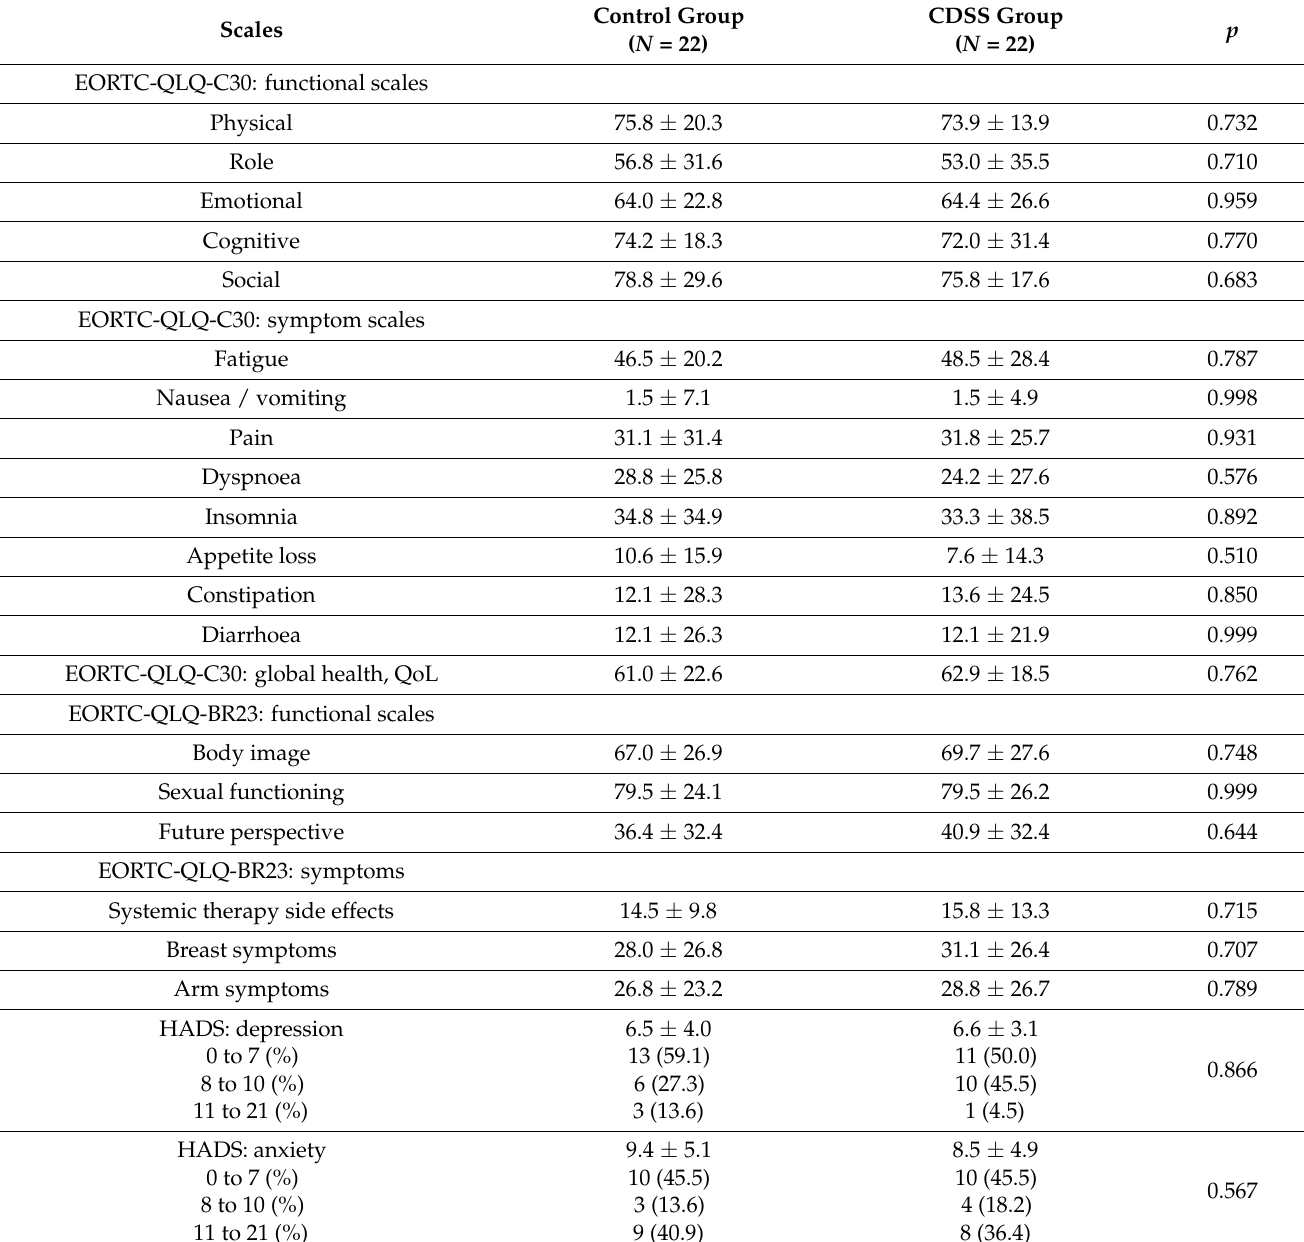
Table 2. Health-related quality of life, anxiety and depression scales at baseline.